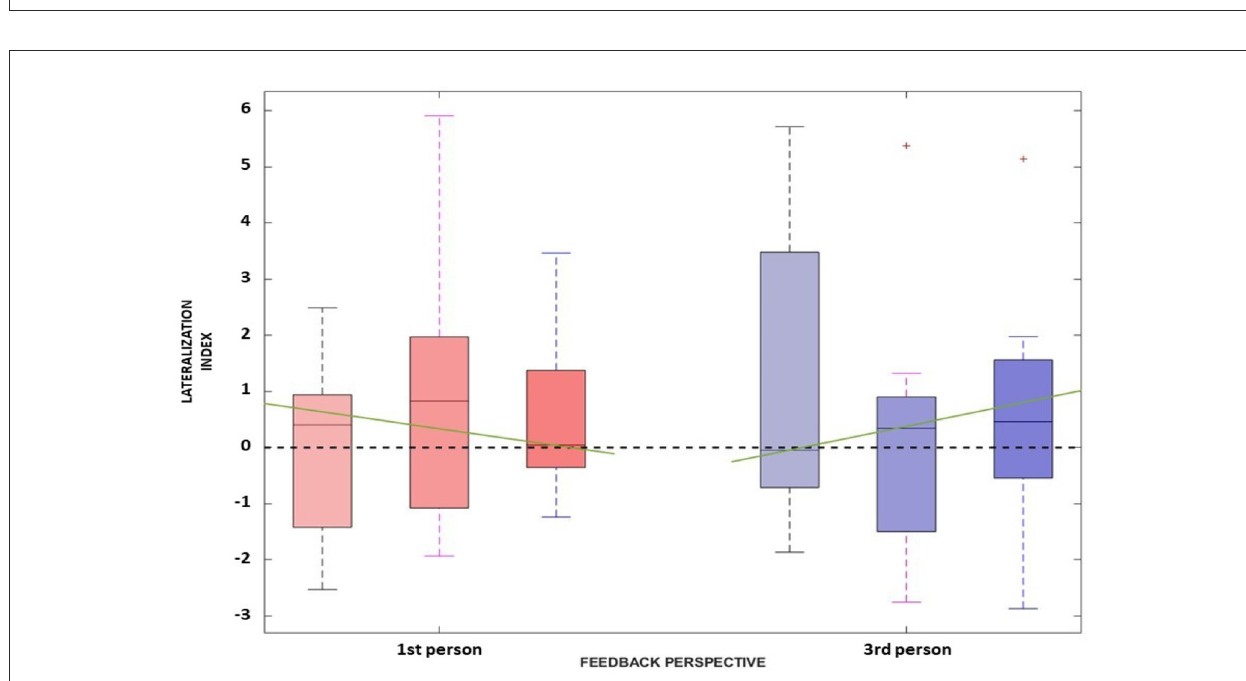
FIGURE6 The Lateralization Index distributions along the three sessions for the first-person perspective (in red) and third-person perspective (in blue) are reported. The green line represents the interpolation of the medians obtained in the three sessions for each feedback condition.